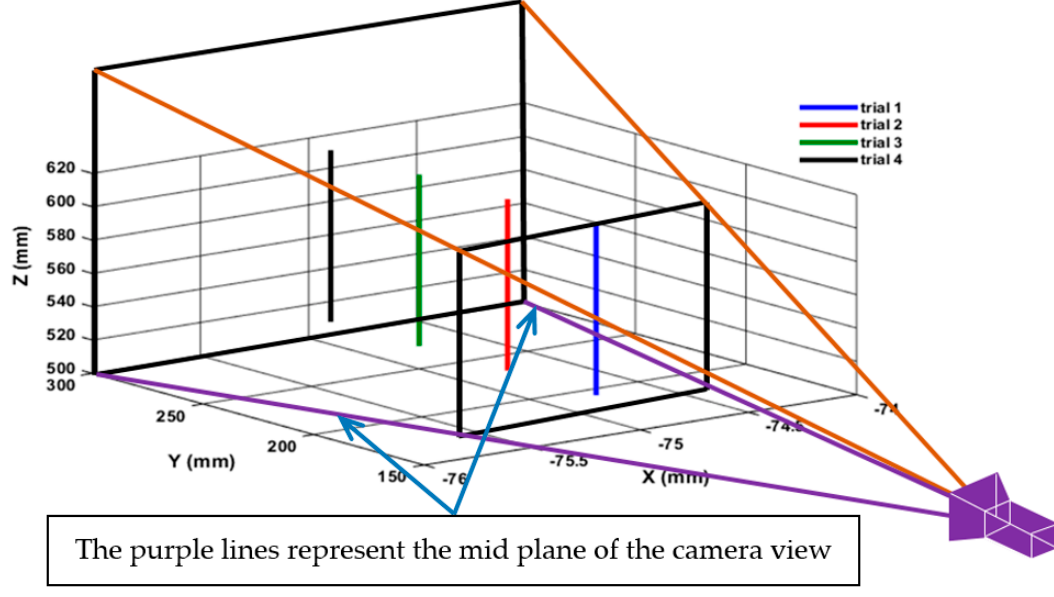
Figure 8. Nominal movements of the target. Table 4. The influence of the changing depth on the measurement accuracy of the tracking system.